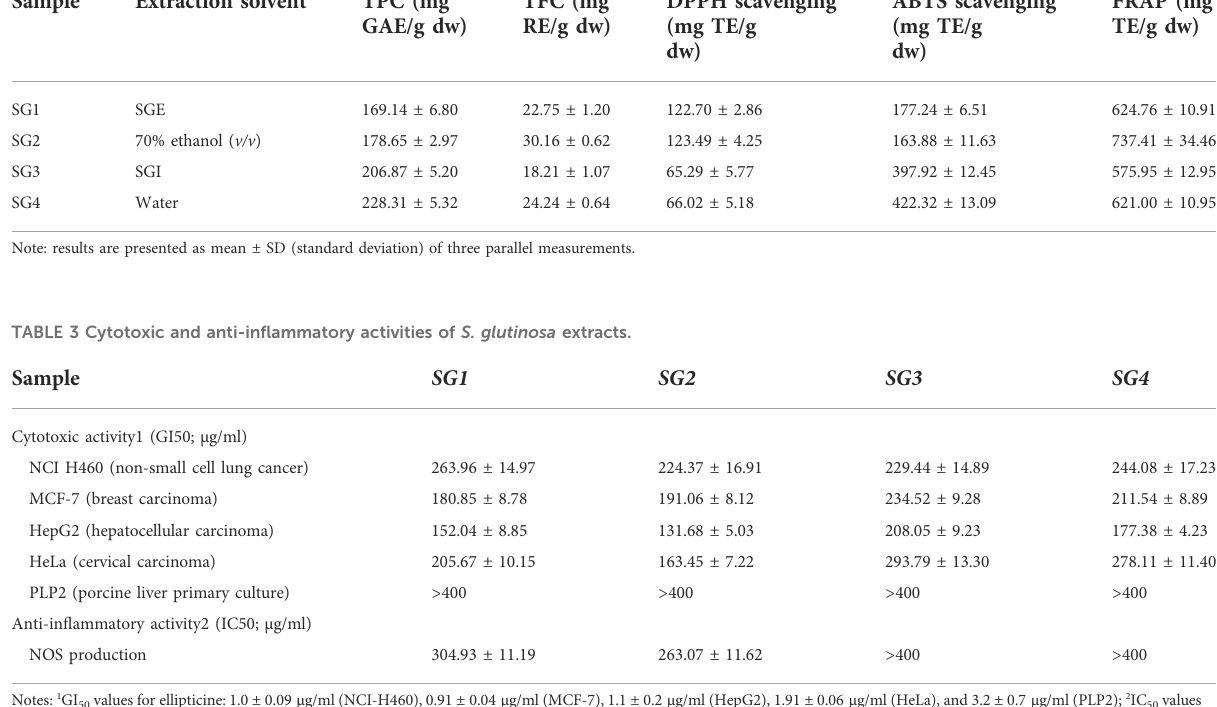
TABLE 2 Comparison of total phenolic and fl avonoid content, and in vitro antioxidant capacity (using the DPPH, ABTS, and FRAP assays) of the extracts of S. glutinosa . Sample